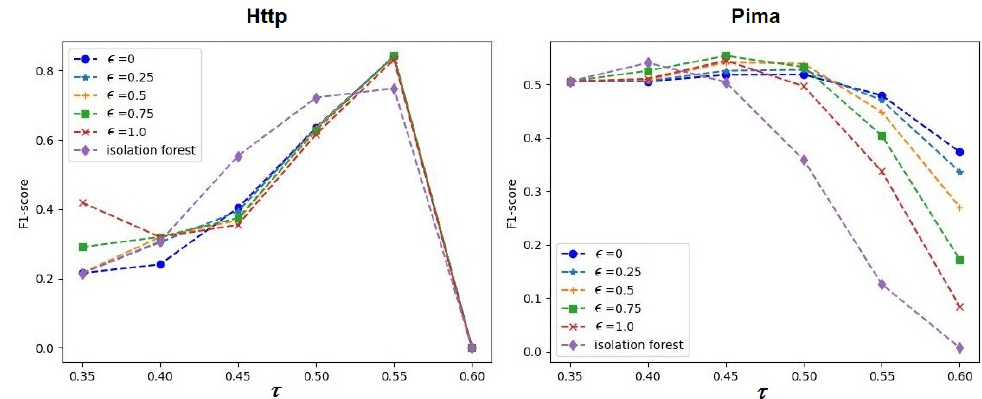
Figure 13. Comparison of iForest and ABIForest with different thresholds τ and with different contamination parameters (cid:101) for the Http (the left panel) and Pima (the right panel)